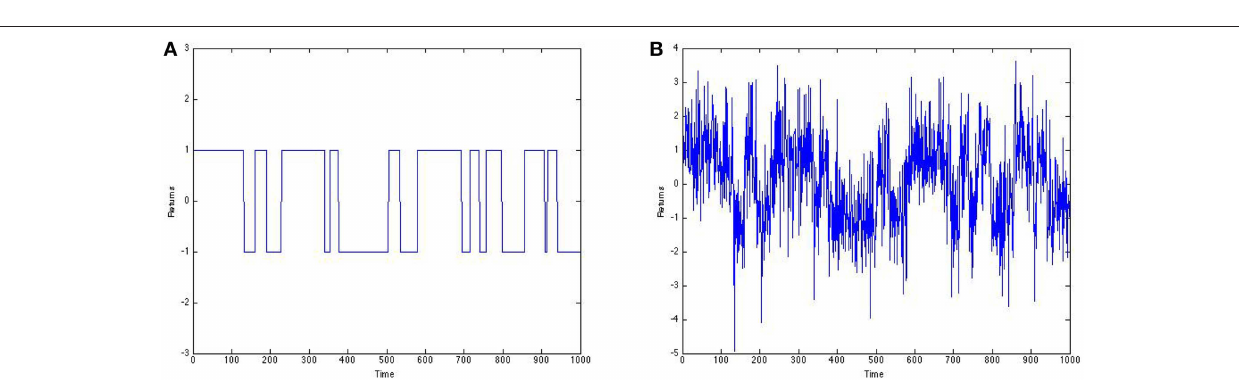
FIGURE 4 | Binary big order return series before (A) and after (B) it has been corrupted by